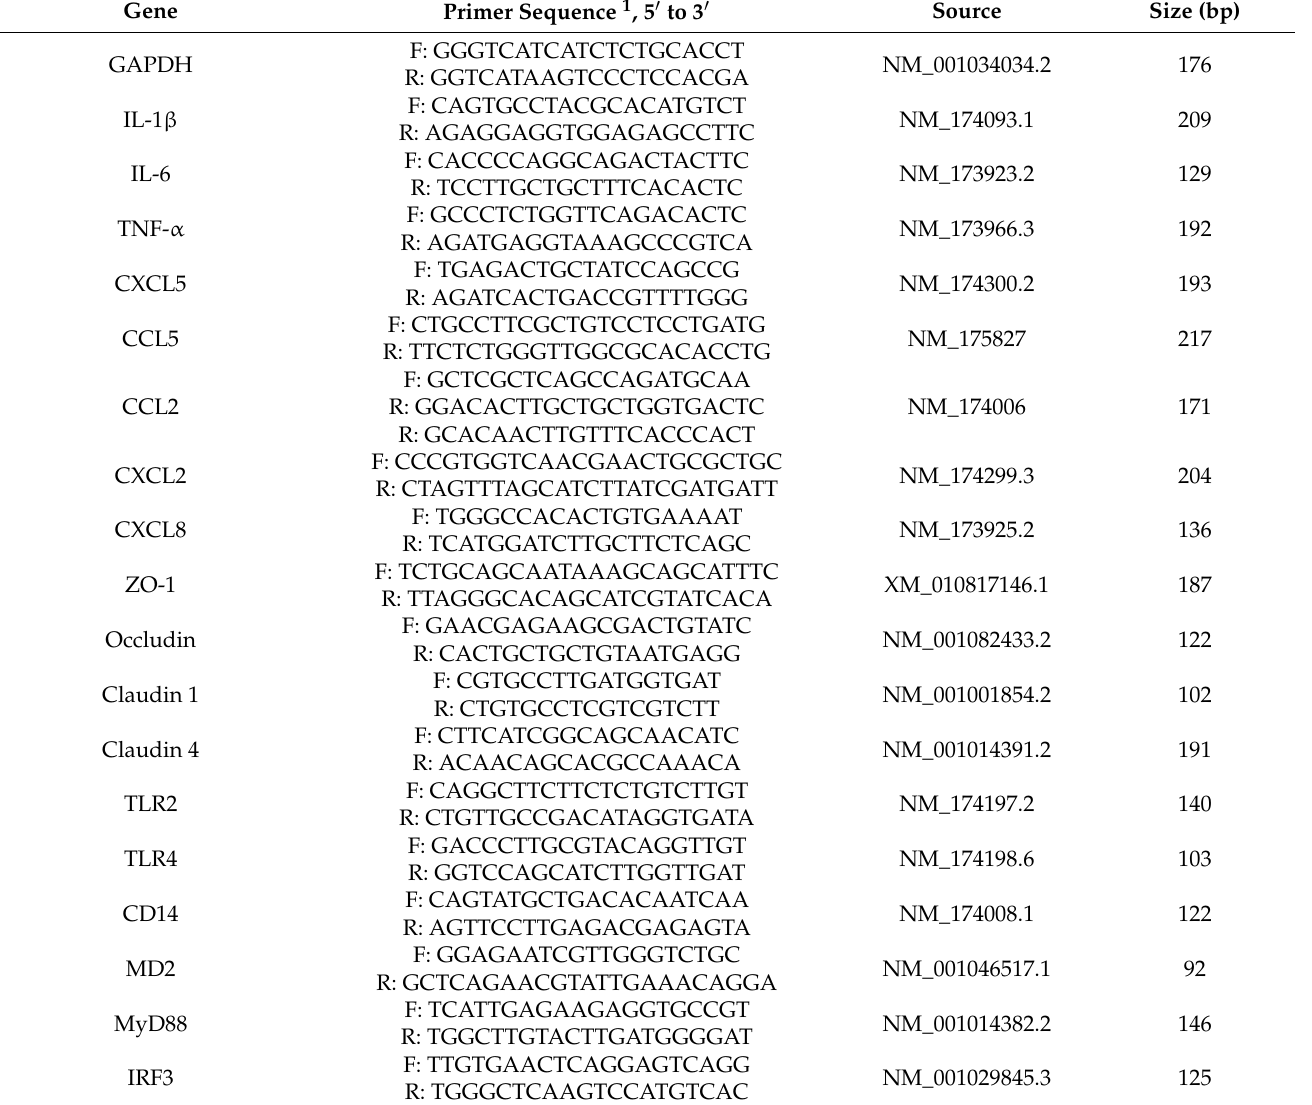
Table 1. Primers for real-time quantitative